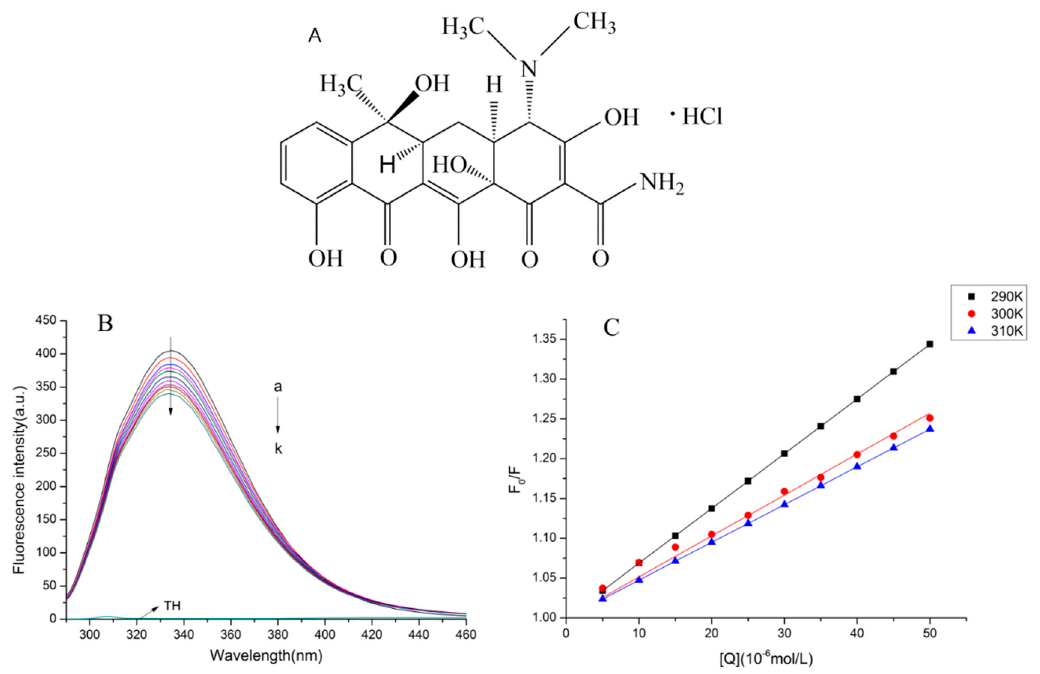
Figure 1. ( A ) The chemical structure of tetracycline hydrochloride (TCH). ( B ) Effect of TCH on fluorescence spectra of bovine lactoferrin (bLf). ( C ) The Stern–Volmer plots for the quenching of bLf by TCH at different temperatures.